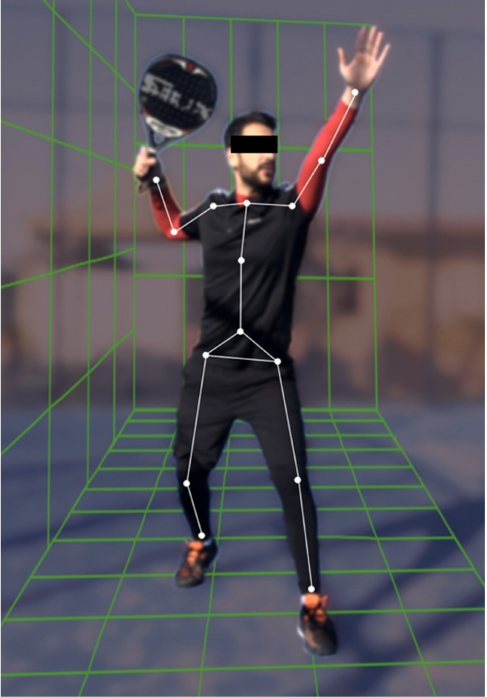
Figure 1. Smash is one of the most used and effective overhead